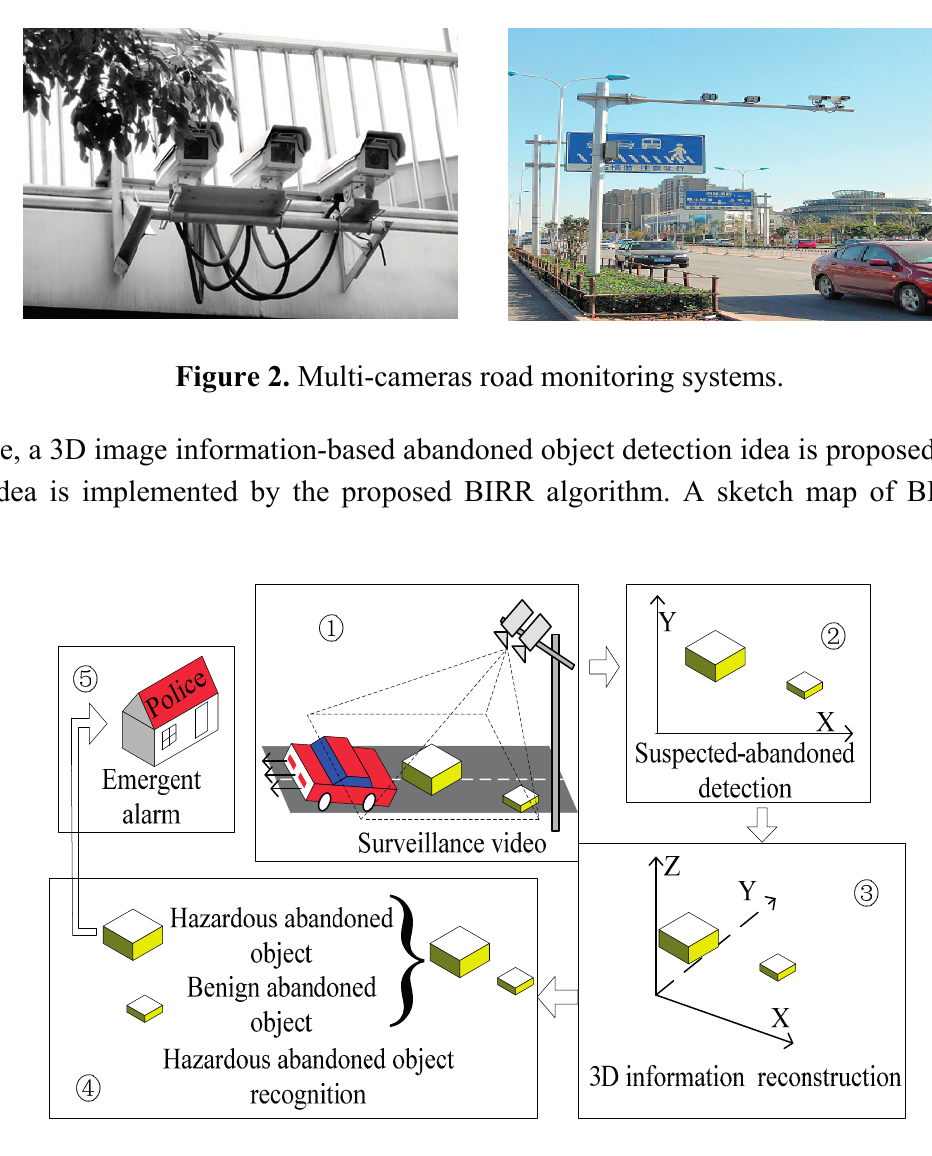
Figure 3. Sketch map of